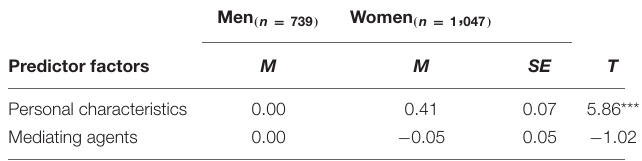
TABLE 4 | Comparisons of the means of the model’s predictor factors by gender. Men ( n = 739 )